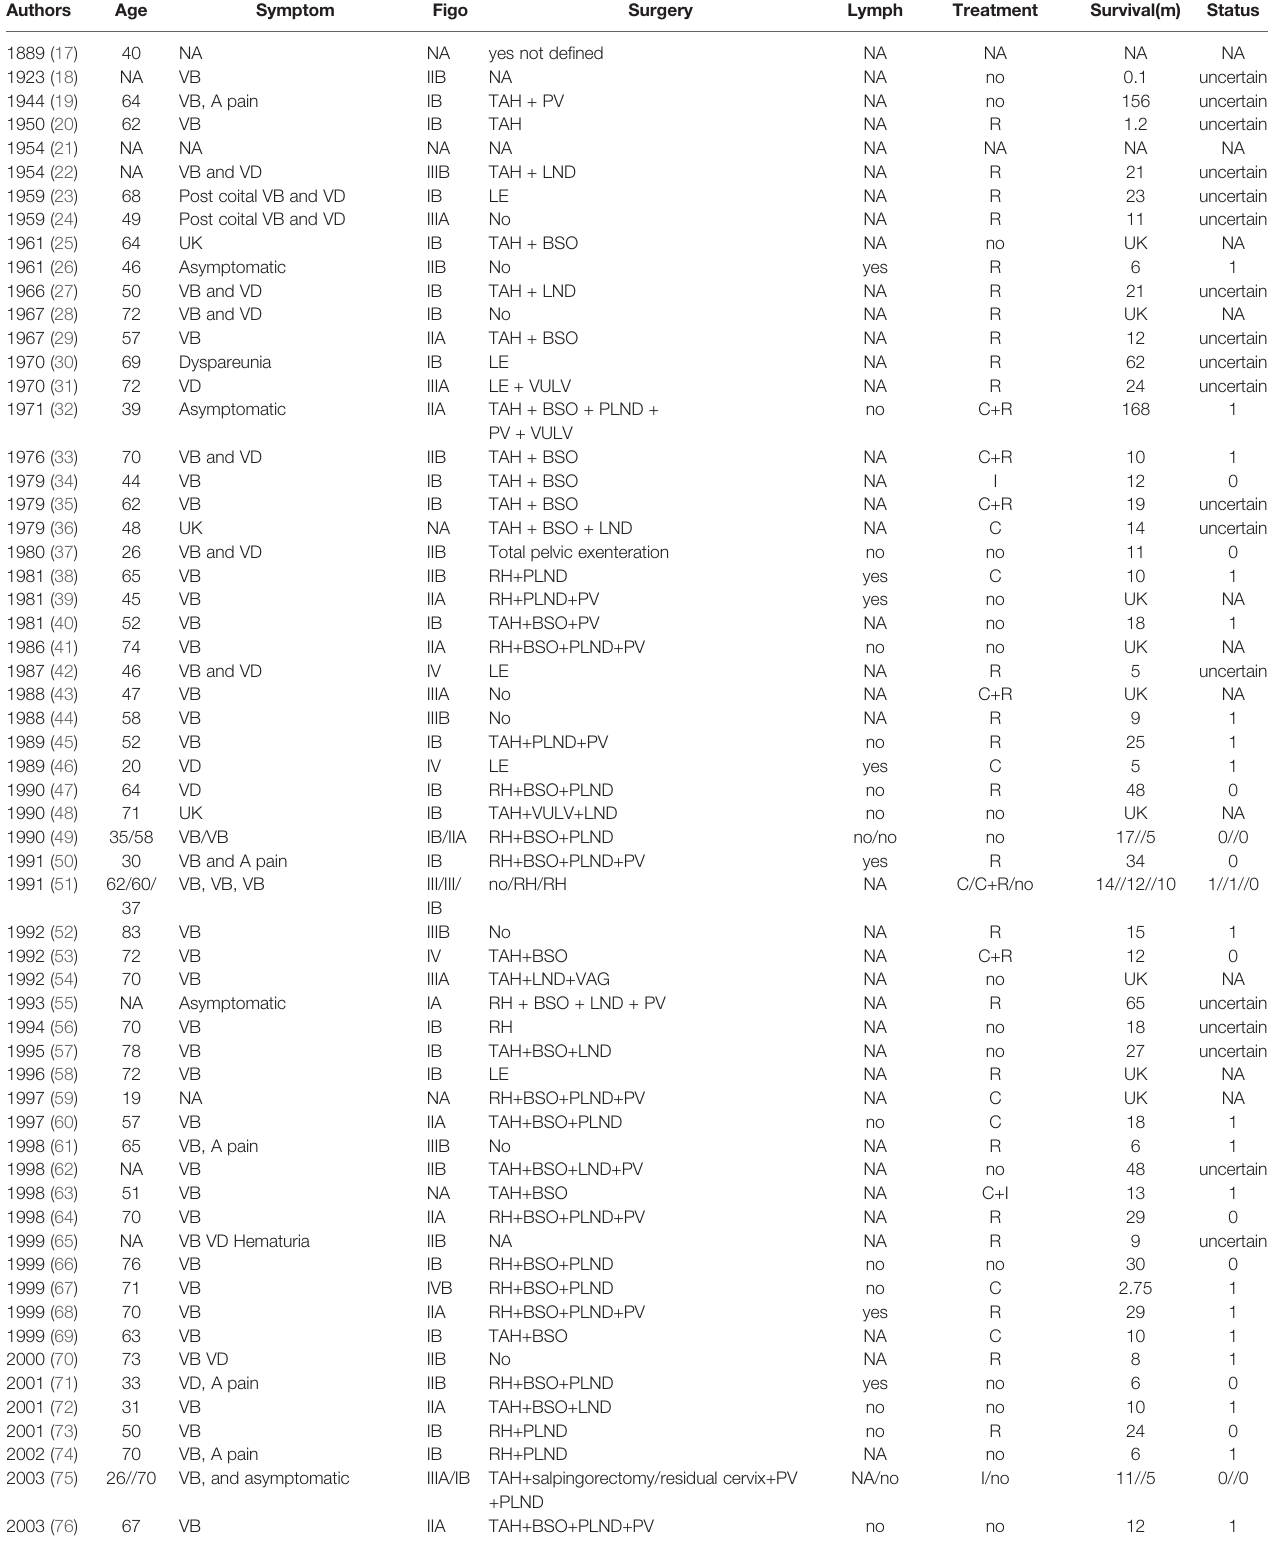
TABLE 1 | Main features of the included